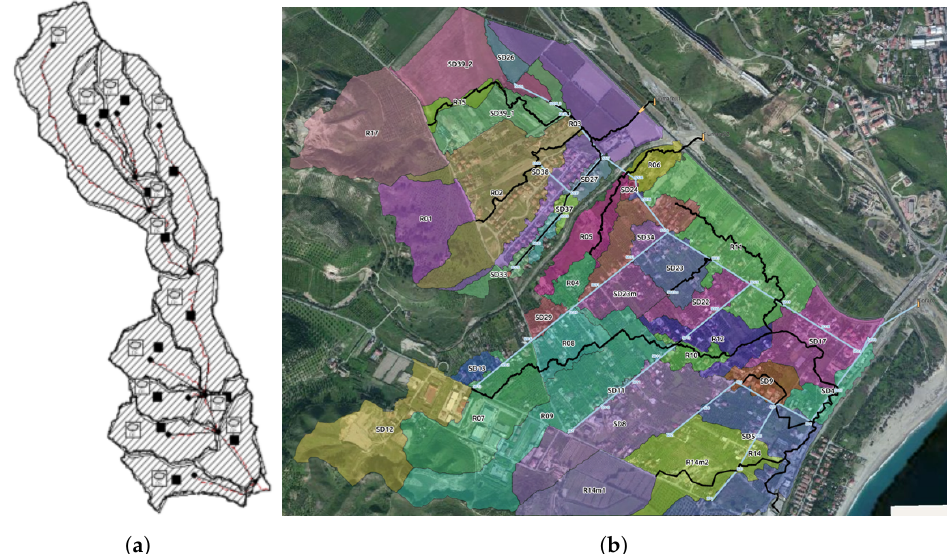
Figure 5. Discretisation of the Corace watershed (Calabria, Southern Italy) in hydrologically homogenous units using the SWMM model (( a ) entire watershed; ( b ) urban area with the delineated